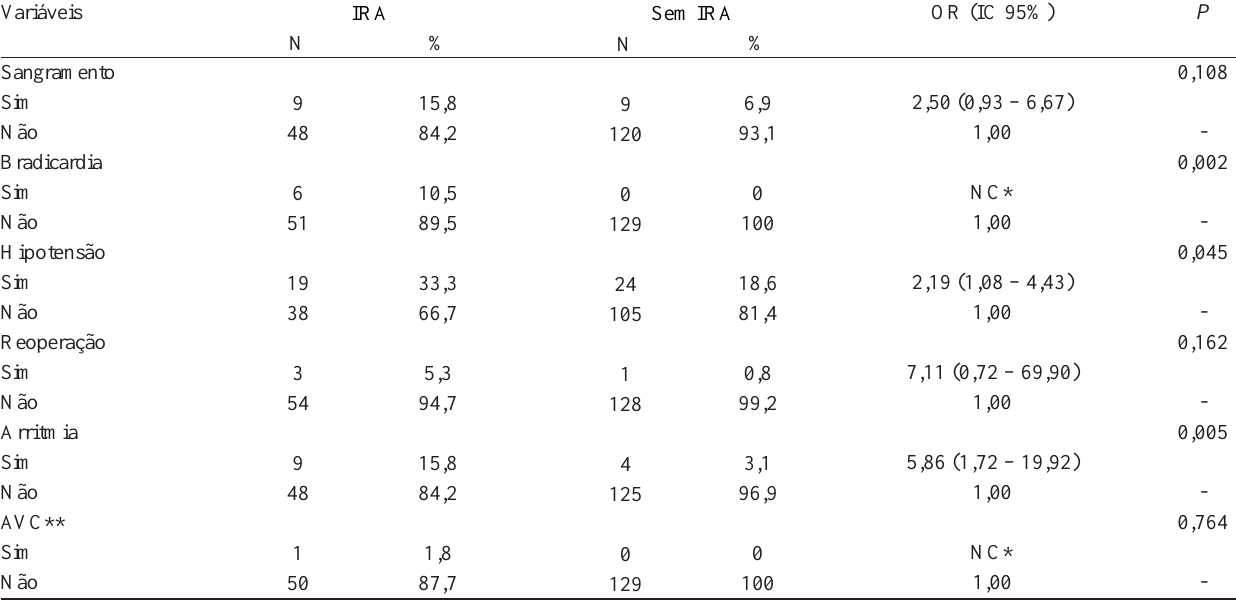
*NC = Não calculado; **AVC = Acidente Vascular